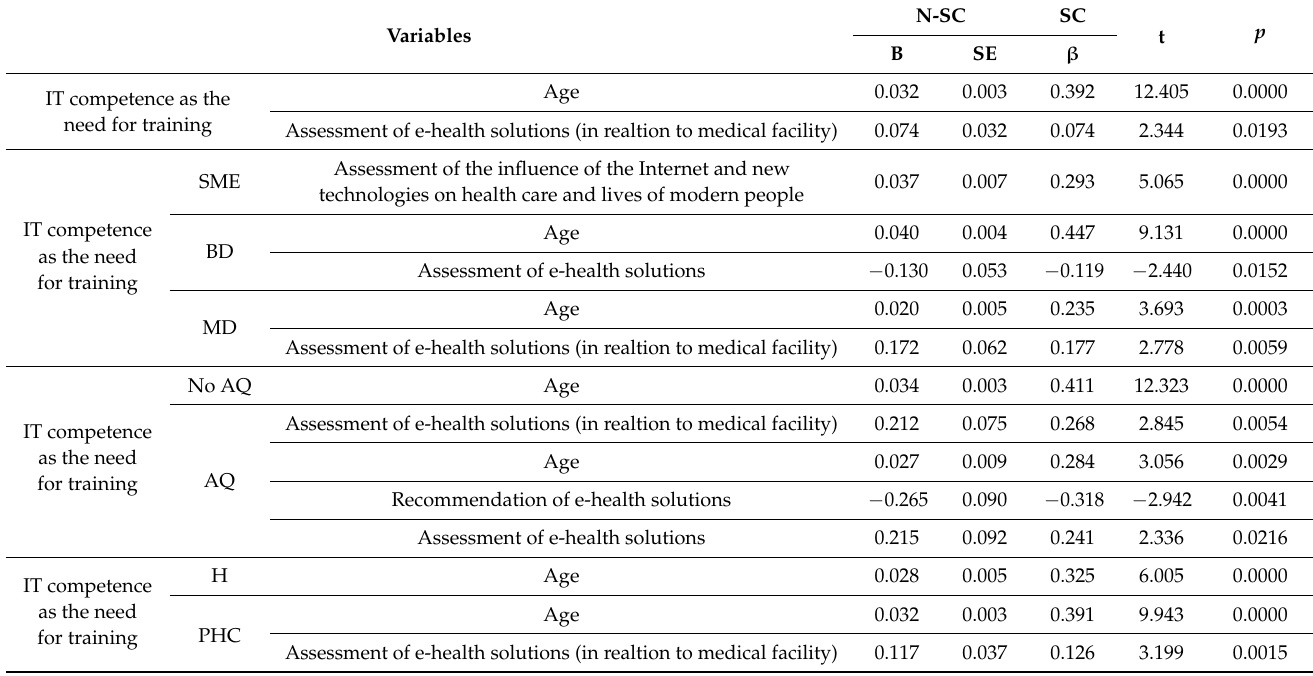
Table 8. Nurses’ IT competence in relation the need for training depending on selected variables (assessment of the influence of the Internet and new technologies on health care and lives of modern people, assessment of the e-health solutions (generally and in relation to medical facility, recommendations of e-health solutions and age of